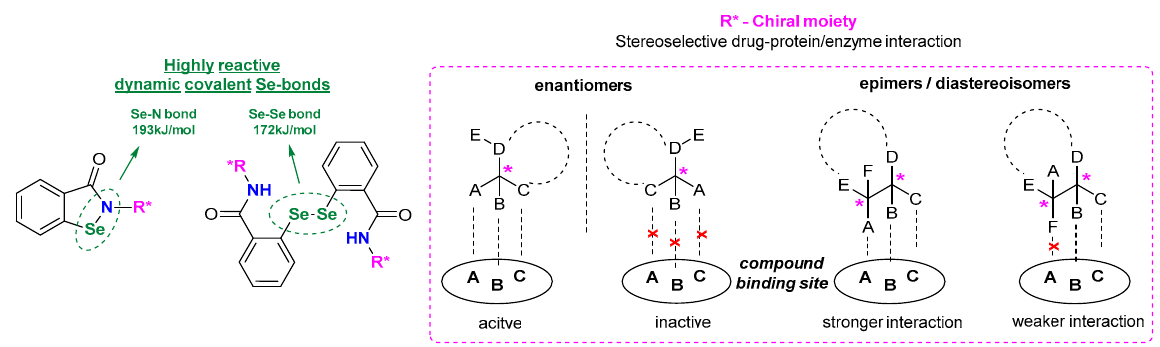
Figure 2. Structural features of the designed compounds—interaction with the target binding sites.